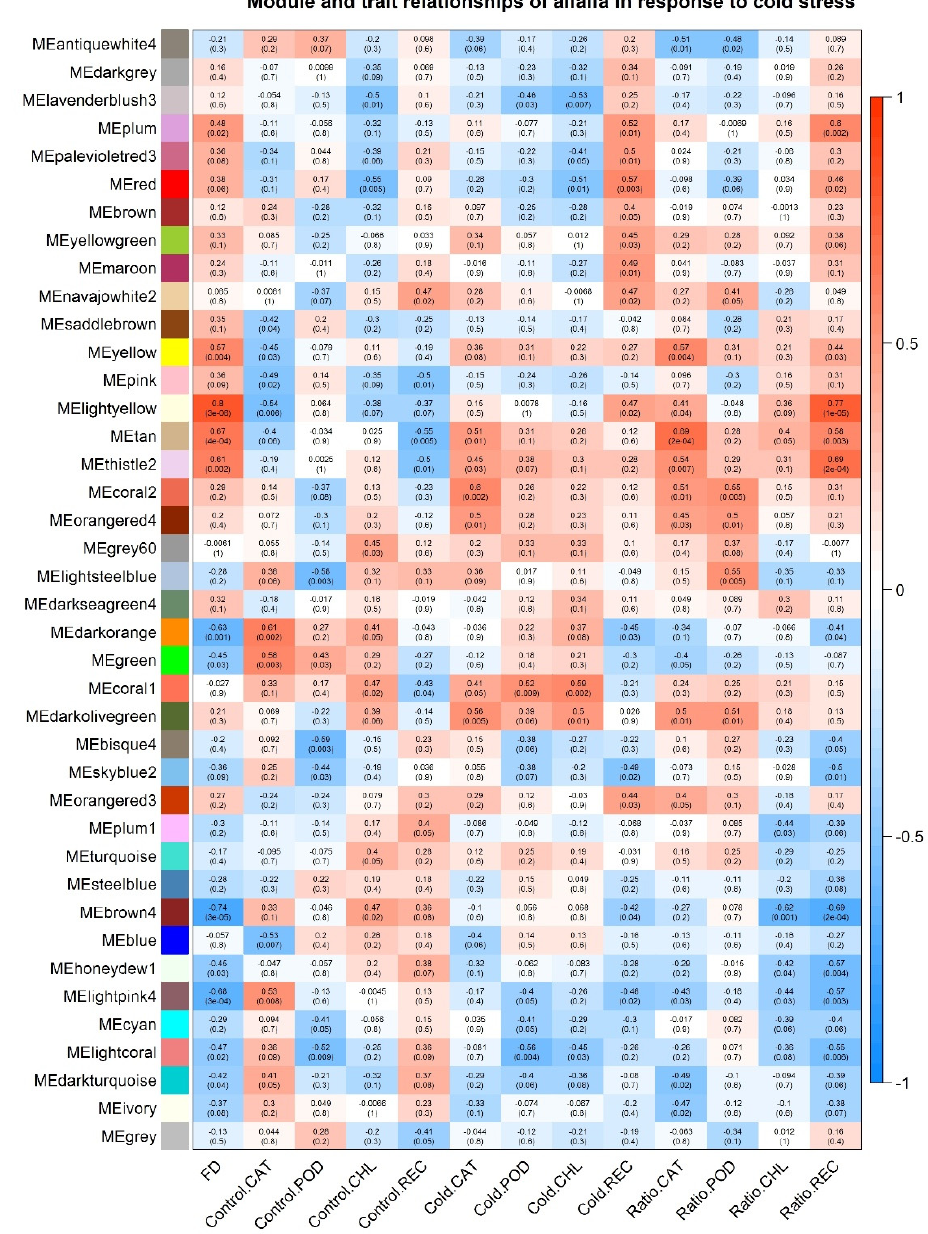
Figure 5. Module-trait associations with the application of WGCNA. Note: Each row corresponds to a module eigengene from their expressional levels and each column to a trait, including FD and physiological metabolic assays. Each cell contains the Pearson correlations and p -value of statistical analysis concerning correlations, and the cells were colored based on the Pearson correlations. Red represents a positive coefficient, while blue represents a negative coefficient. FD: fall dormancy; Control: control group; Cold: the group treated with cold stress; and Ratio: the value of the cold stress treated group normalized to that of the control group.